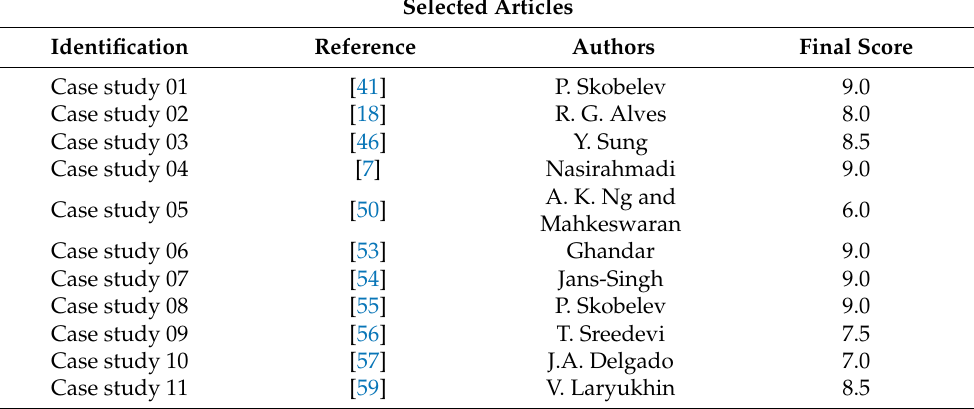
Table 13. Selected